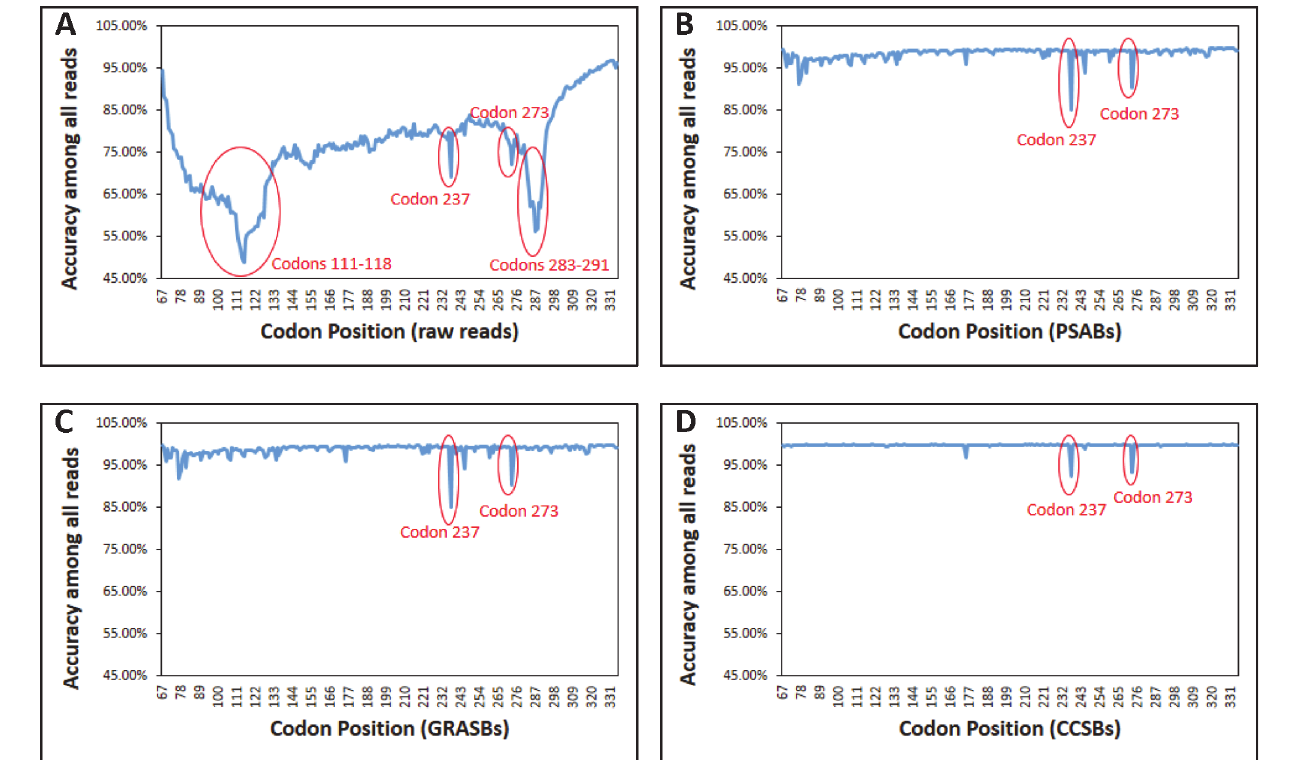
Fig 2. The average accuracy of reads at each codon position in M237I sample set in (A) Raw reads, (B) PSABs, (C) GRASBs, and (D) CCSBs. The regions with lower accuracy than their neighbors are